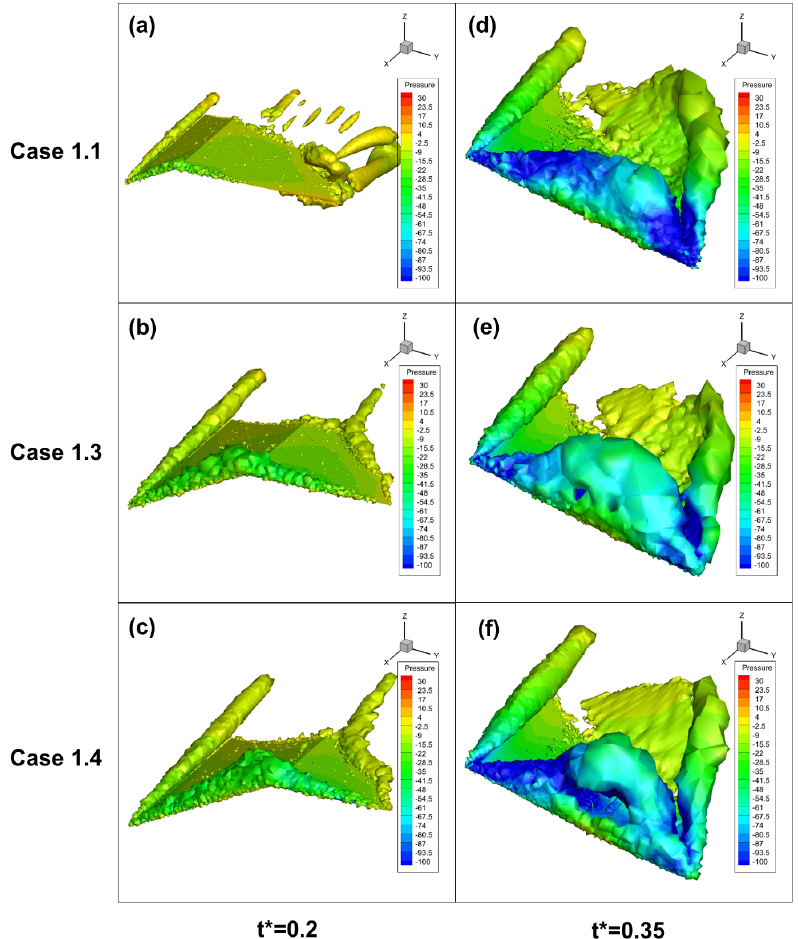
Figure 8. Vorticity during downstroke of typical cases: ( a ) case 1.1 at t* = 0.2; ( b ) case 1.3 at t* = 0.2; ( c ) case 1.4 at t* = 0.2; ( d ) case 1.1 at t* = 0.35; ( e ) case 1.3 at t* = 0.35; ( f ) case 1.4 at t* = 0.35.